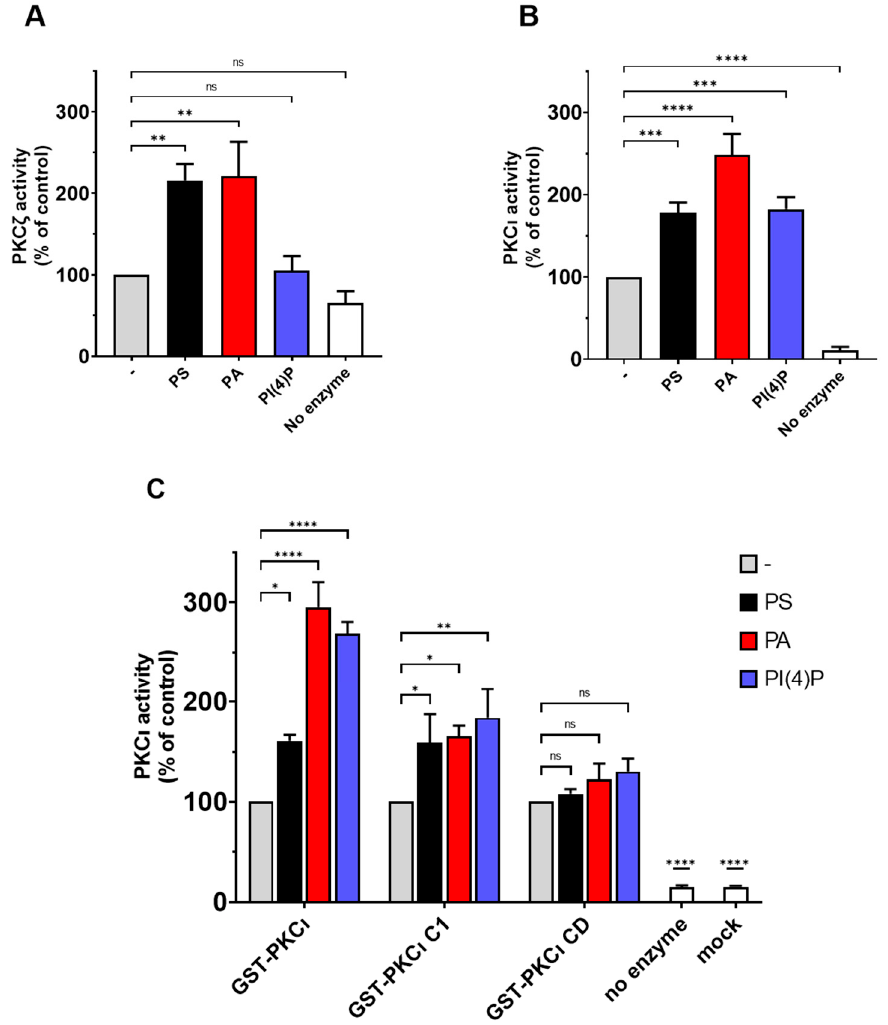
Figure 4. PKC ι is activated by PS, PA, and PI(4)P. ( A ) The activity of commercial purified GST- PKC ζ was measured in the presence of 50-µg/mL PS or PA or PI(4)P. A complete reaction without an enzyme is considered as the negative control. ( B ) The activity of commercial purified GST-PKC ι was measured in presence of 50- µ g/mL PS or PA or PI(4)P. A complete reaction without an enzyme is considered as the negative control. ( C ) The activity of in-house purified GST-PKC ι and deletion mutants was measured in presence of 0.5-ng/mL PS or PA or PI(4)P. Mock purification and no enzyme conditions are used as negative controls. Data are the mean ± SEM of at least 4 independent experiments performed in triplicate. A single, double, triple and four asterisks denote their significance of p -value ≤ 0.05, ≤ 0.01, ≤ 0.001 and ≤ 0.0001 respectively, ns mean No signifi- cant.